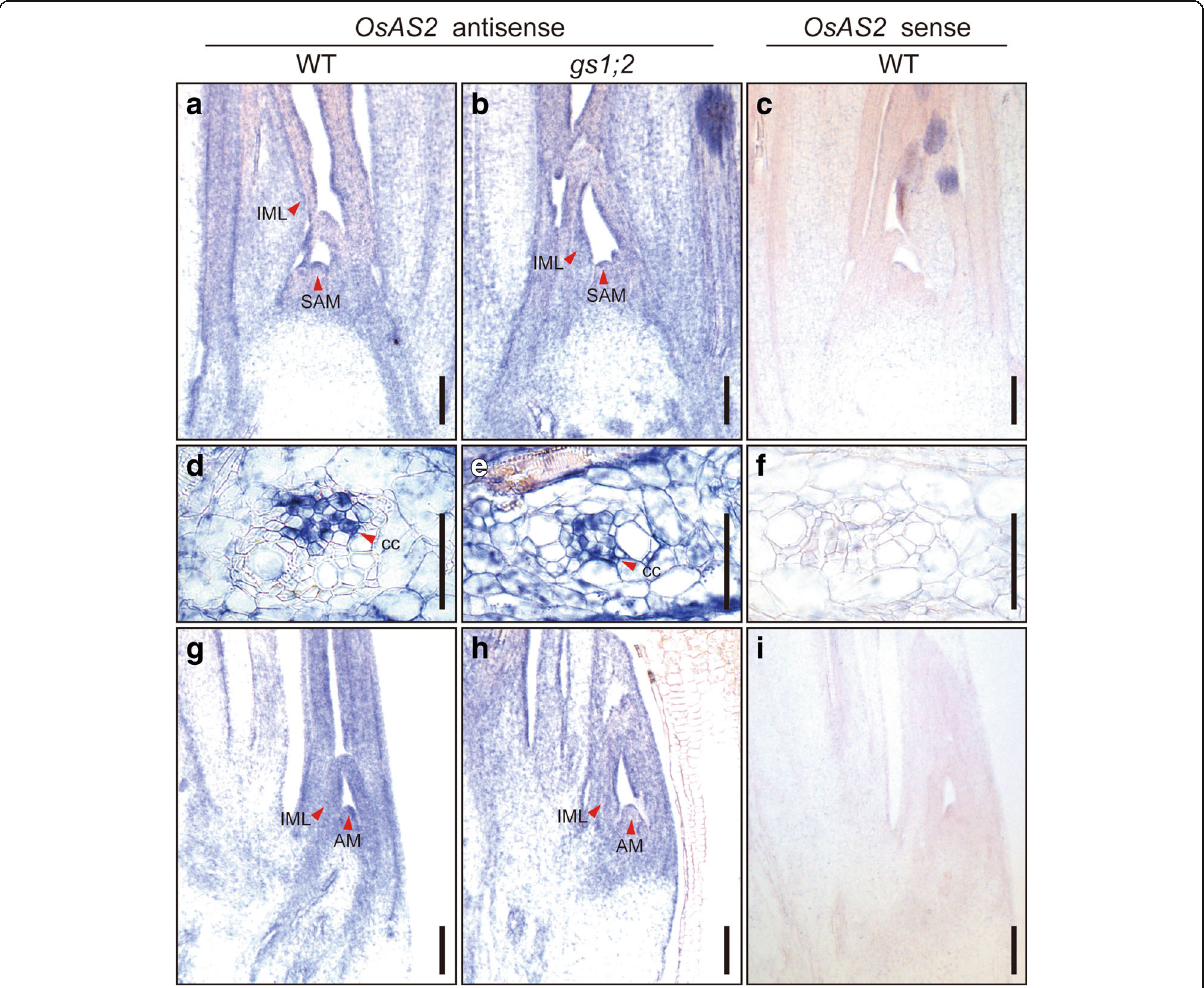
Fig. 3 In situ hybridization for OsAS2 in the basal portions of wild-type and gs1;2 mutant shoots. Longitudinal sections of basal portions of shoots were prepared from the wild-type rice (WT) ( a , c , d , f , g , i ) and the gs1;2 mutants ( gs1;2 ) ( b , e , h ) grown hydroponically in the presence of 1 mM NH 4 Cl until the fourth-leaf stage. A sense probe was hybridized to WT sections ( c , f , i ) as a negative control. Red arrowheads indicate hybridization signals for OsAS2 transcripts in the shoot apical meristem (SAM) ( a , b ), phloem companion cell of the nodal vascular anastomoses (cc) ( d , e ), an immature leaf (IML) area ( a , b , g , h ), and the tiller containing the axillary bud meristem (AM) ( g , h ). Scale bars=100 μ m ( a - c , g - i ) and 50 μ m ( d - f